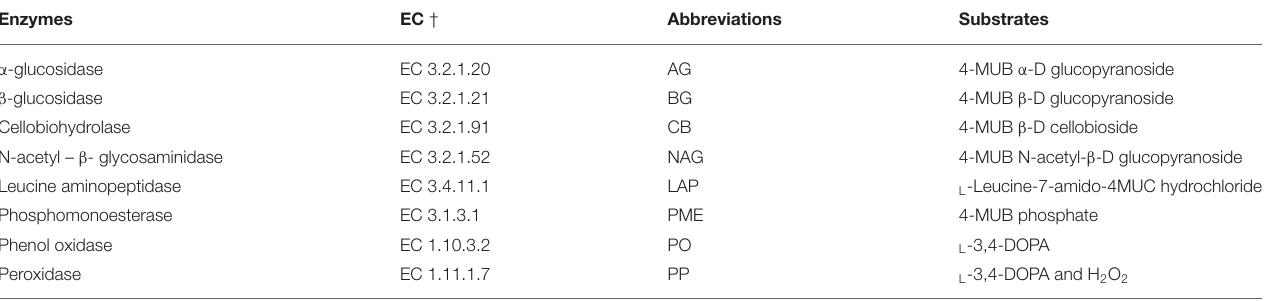
† EC, enzyme code; defined by the Nomenclature Committee of the International Union of Biochemistry and Molecular Biology (NC-IUBMB).